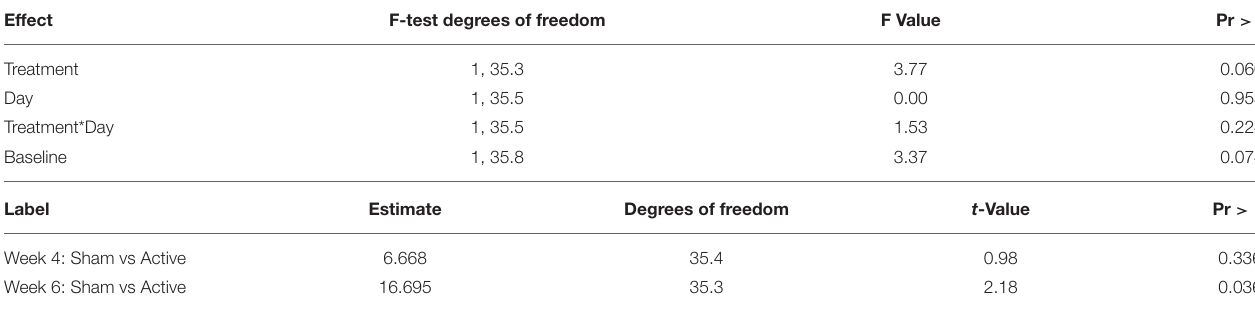
TABLE 3 | Results of repeated-measures ANOVA evaluating treatment (sham vs. active), and time